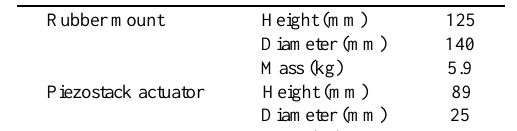
Table 2 Dimensional specifications of the proposed hybrid mount